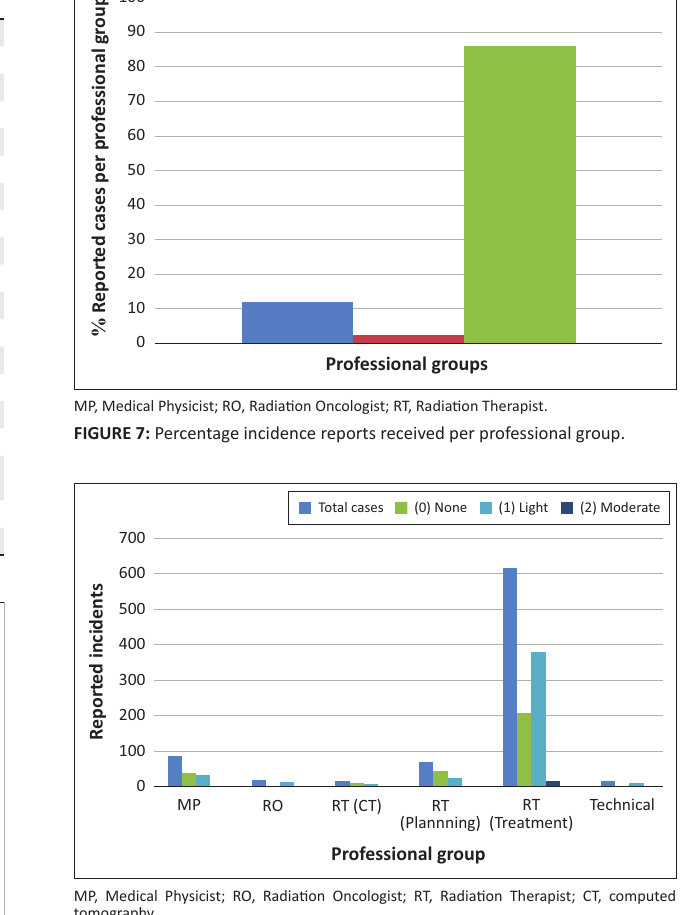
TABLE 1: Treatment sites percentage per annum. Tumours treated between 01 September 2015 and 31 August 2016. ICD10 code